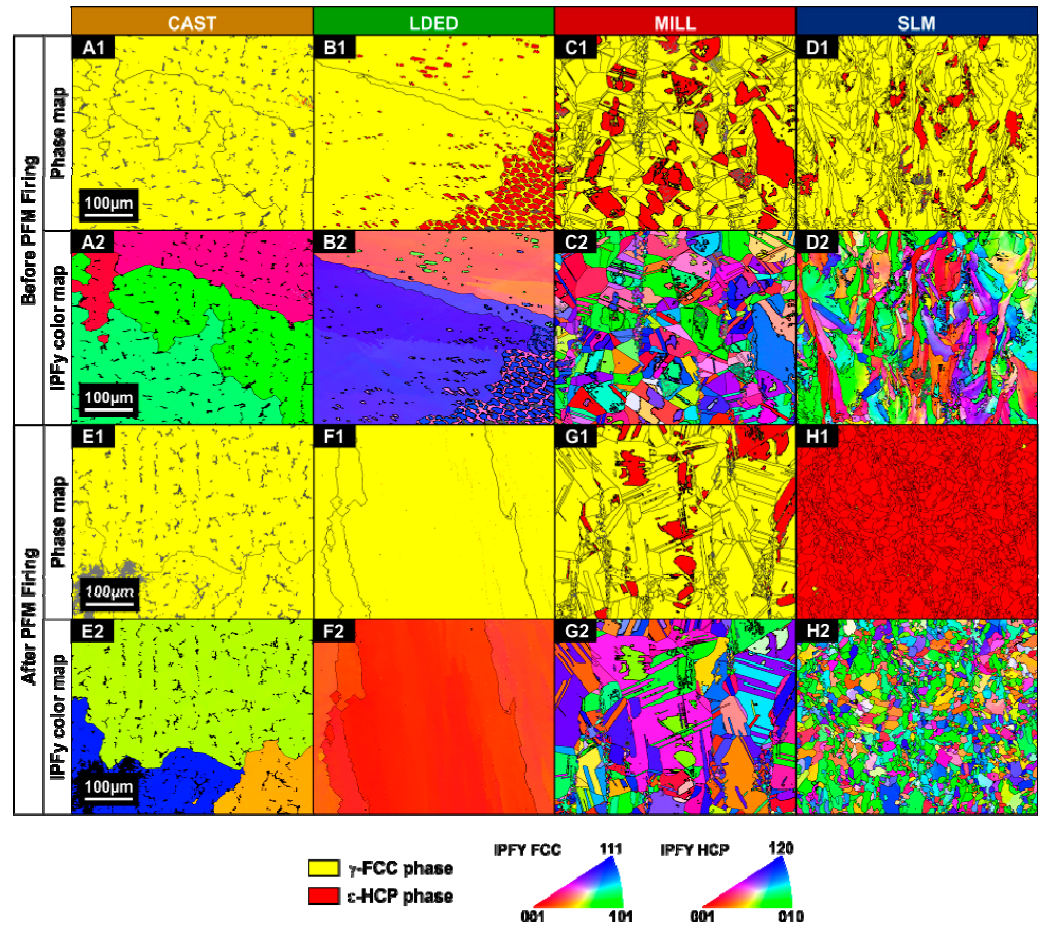
Figure 5. Electron backscatter diffraction (EBSD) phase maps ( 1 ) and IPFy (Inverse Pole Figure, y axis) color maps ( 2 ) showing a longitudinal section of each fabrication technique, before ( A – D ) and after ( E – H ) PFM firing simulation.